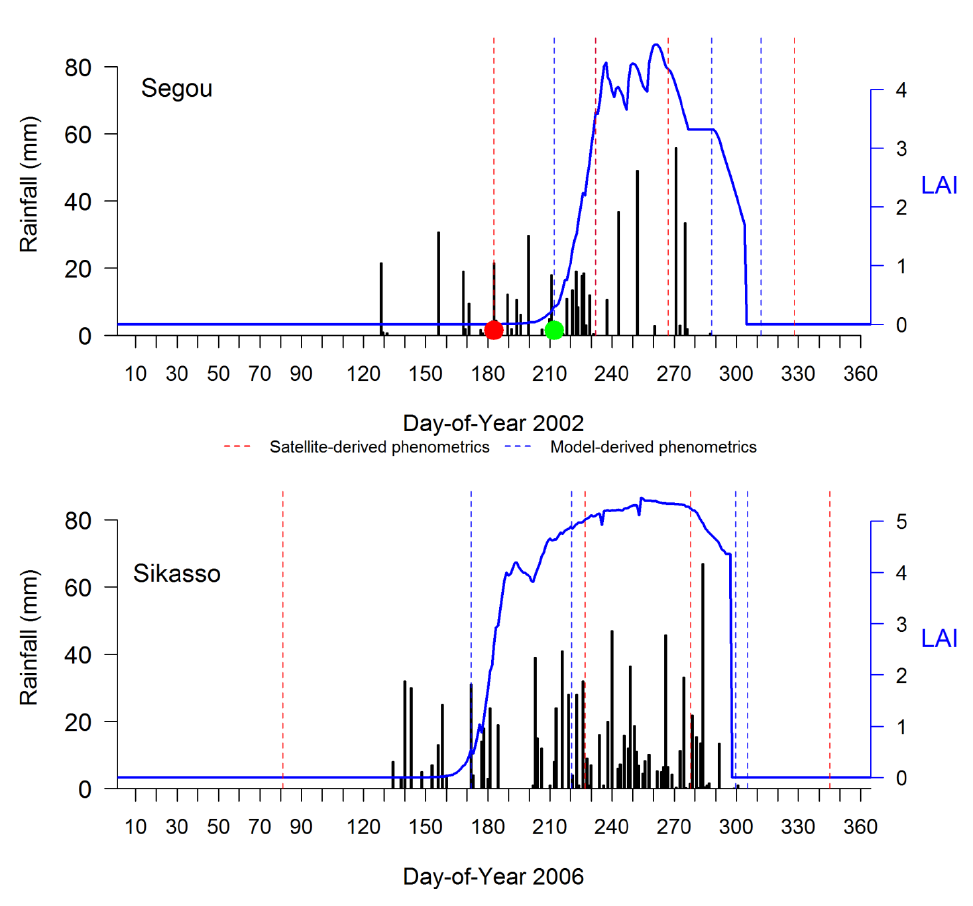
Figure 9. Rainfall (mm), LAI simulation (blue curve) and model- (dotted blue lines) and satellite-derived (dotted red lines) phenometric barplots for the two years, which indicate inconsistencies (Segou in 2002 and Sikasso in 2006), including for the LAI millet choho simulation in Segou and sorghum guinea in Sikasso (blue curve). From left to right, the dotted lines correspond to the start-of-season, start-of-maximum of season, end-of-maximum of season, and end-of-season, respectively. The red circle indicates a failed sowing date, and the green circle indicates a successful sowing